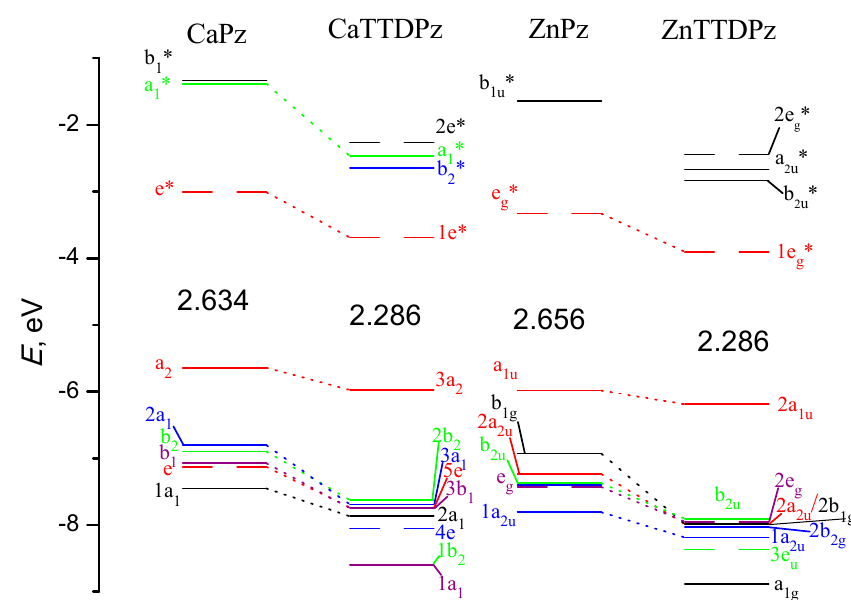
Figure 6. Molecular orbital (MO) level diagram for MPz and MTTDPz complexes (M = Ca, Zn). The values of highest occupied molecular orbital-lowest unoccupied molecular orbital (HOMO-LUMO) gaps are given in eV.